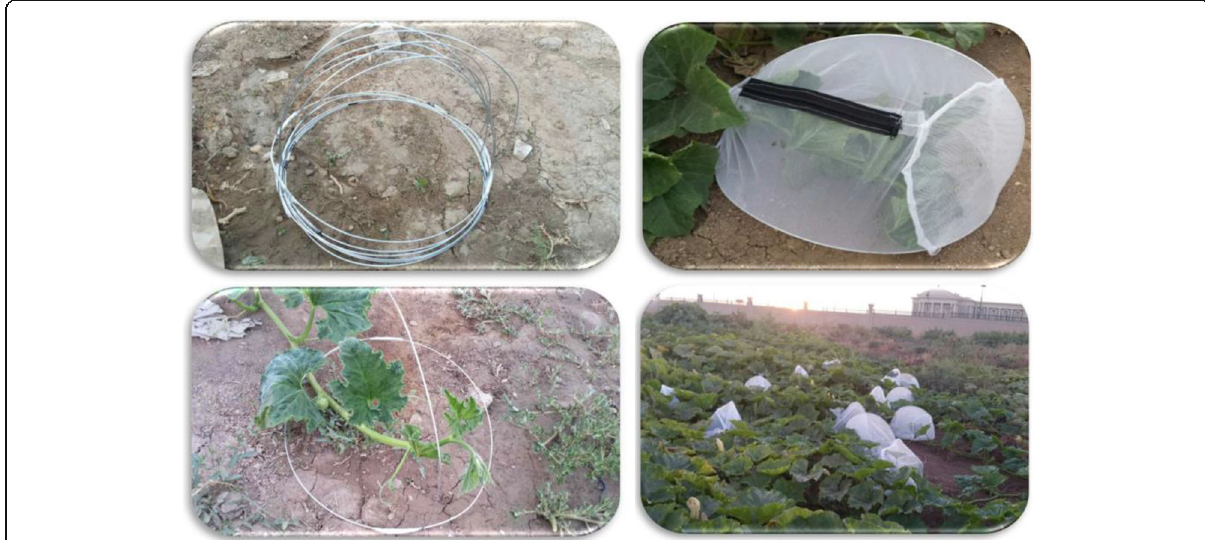
Fig. 1 Cages used for field experiments